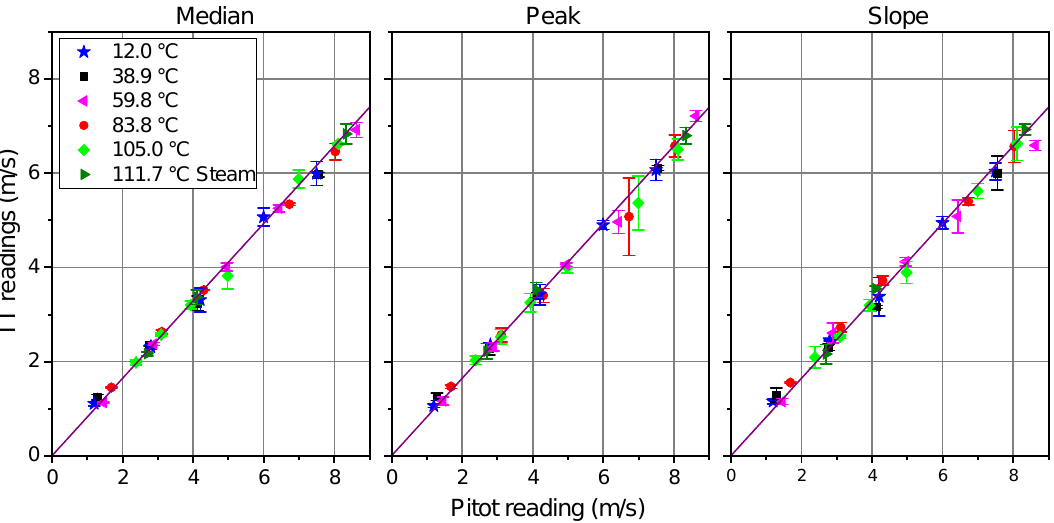
Figure 17. TT readings, with different time stamps, vs. Pitot readings, with manual setting of the Pitot probe for different temperatures and fan speeds. Steam flow rate at 111.7 ◦ C: 60 kg/h (cid:64) 2.7 m/s; 31 kg/h (cid:64) 4.1 m/s; 18 kg/h (cid:64) 8.3